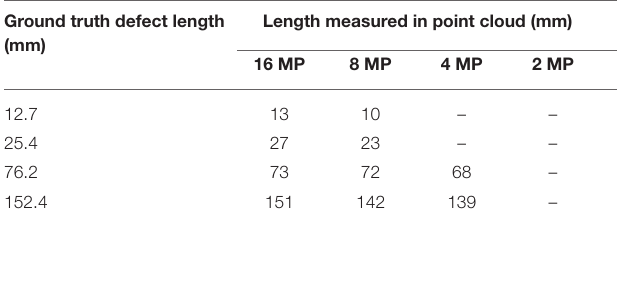
TABLE 8 | Measurement accuracy of type 2 defects at various image resolutions. Ground truth defect length (mm × mm)